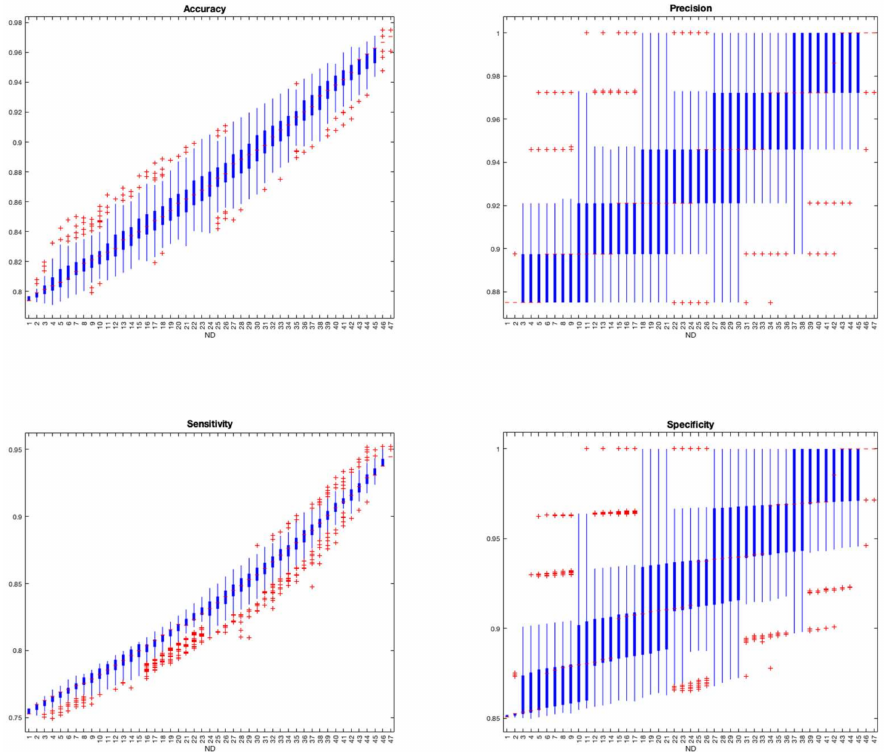
Figure 8. Performance of the CAD system for different ND